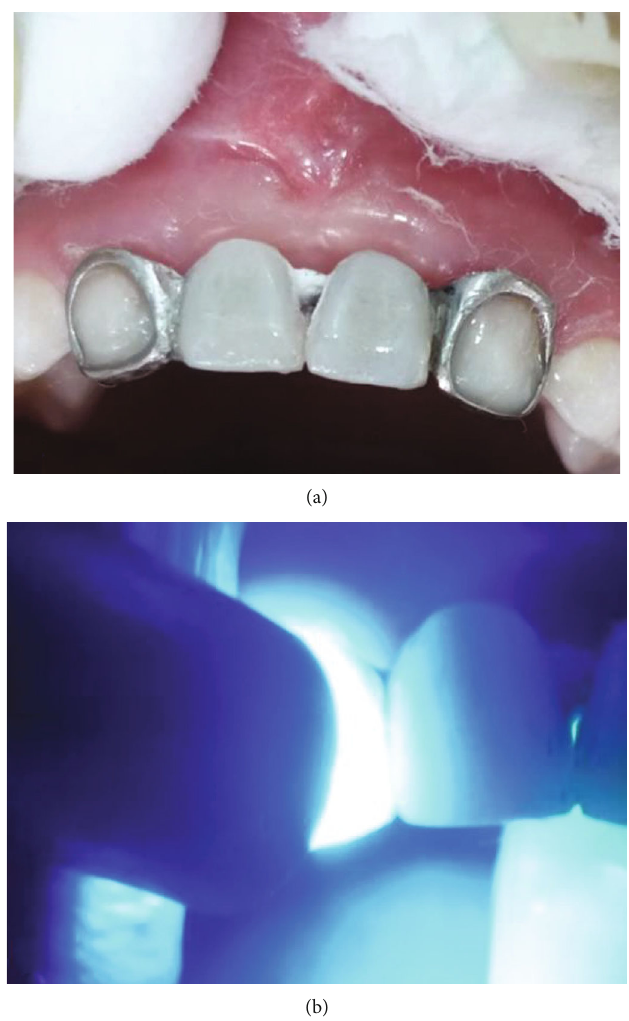
Figure 2: Rehabilitation procedures. (a) Cementation of device. (b)